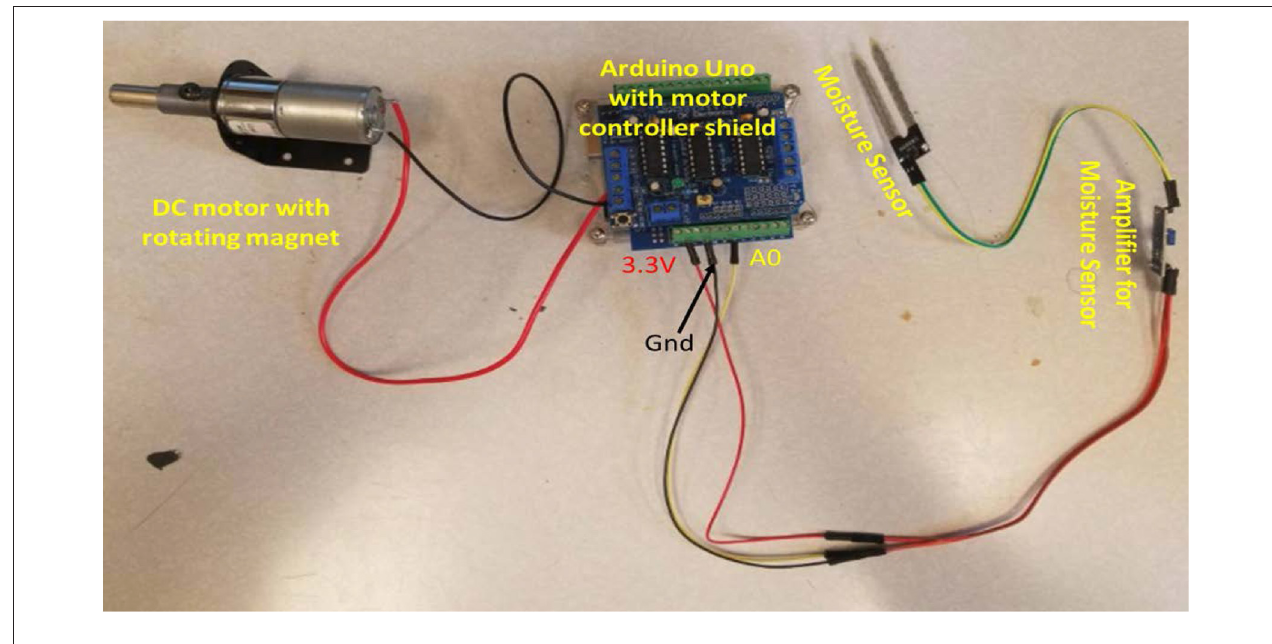
FIGURE 10 | Rotating magnet moisture sensor design.